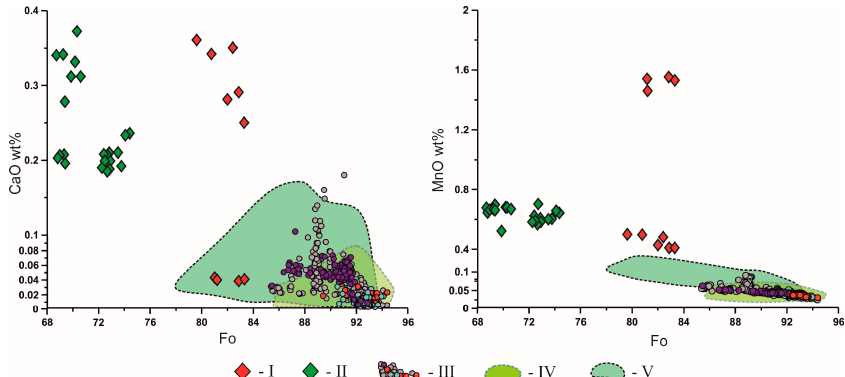
Figure 7. Concentrations of CaO and MnO (wt%) vs. Forsterite (Fo) component in olivine from sample Uv-537 (according to EPMA). Roman numerals stand for: I and II = core and rim of intergranular olivine from studied eclogite xenolith; III = olivine composition from peridotite xenoliths (Udachnaya database, n = 694) [16,55,62,85–87]; IV = olivine inclusions in diamond ( n = 665) [16]; V = olivine from kimberlites ( n = 1179) [88–91].